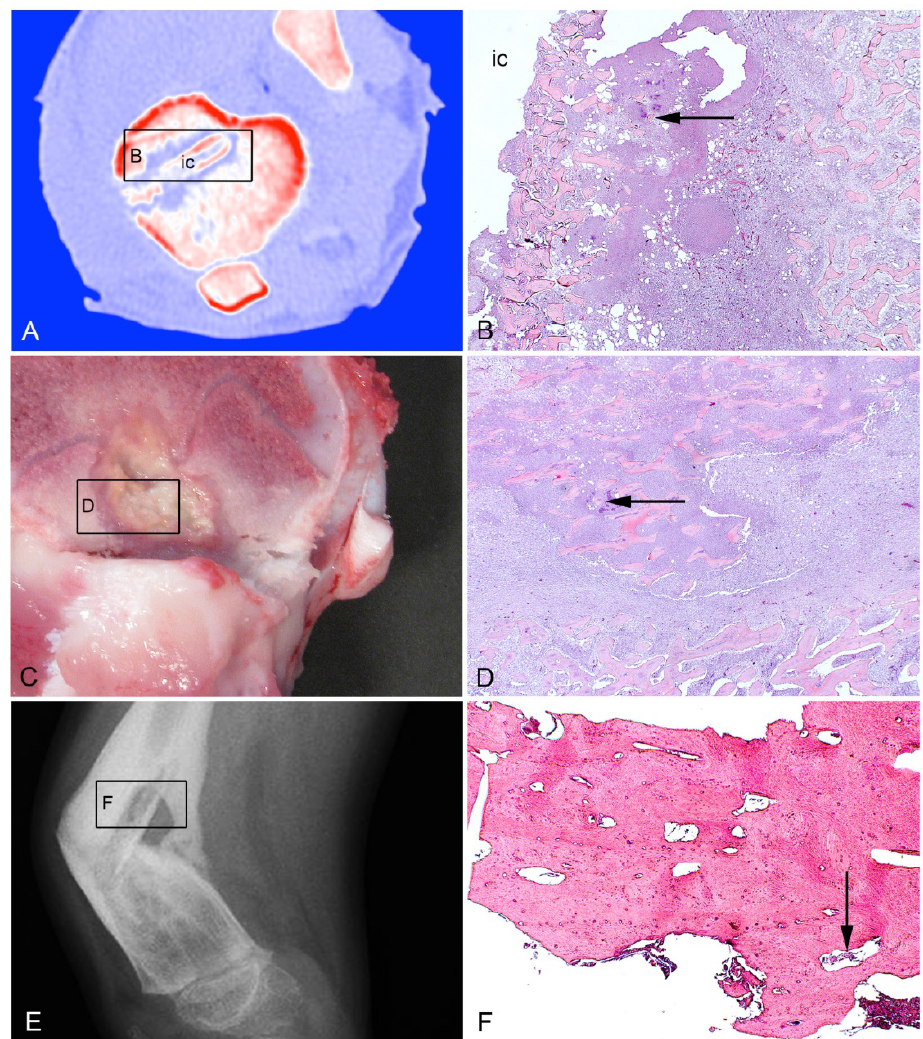
Figure 1. Bone tissue used in the present study. A: Porcine model of implant-associated osteomyelitis. CT scan after five days of inoculation demonstrating the tibial implant cavity (ic) used for injection of S. aureus and insertion of a small steel implant. B: Histology of picture A demonstrating bacteria (arrow) in the peri-implant tissue adjacent to the implant cavity (ic). HE. C: Porcine model of haematogenous osteomyelitis euthanized fifteen days after inoculation. A lesion is shown in the right femoral metaphysis. D: Histology of picture C demonstrating bacteria (arrow) centrally in the lesion. HE. E: X-ray of a child with haematogenous osteomyelitis and pathological fracture in the right femur. F: Histology of picture E demonstrating bacteria (arrow) in a cortical sequester.